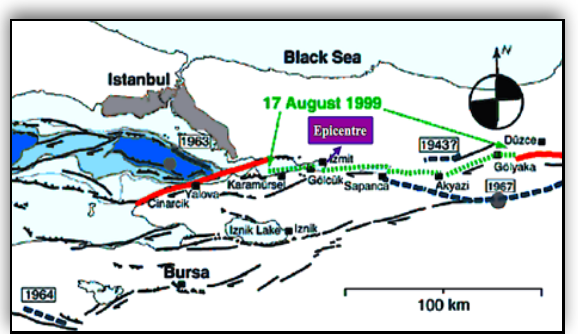
Figure 1: North-western section of the NAF, near Istanbul. The dotted green lines indicate the extent of the 1999 rupture and black lines indicate the fault lines. Red lines reveal the stressed segment after the 1999 earthquake (modified from Barka,